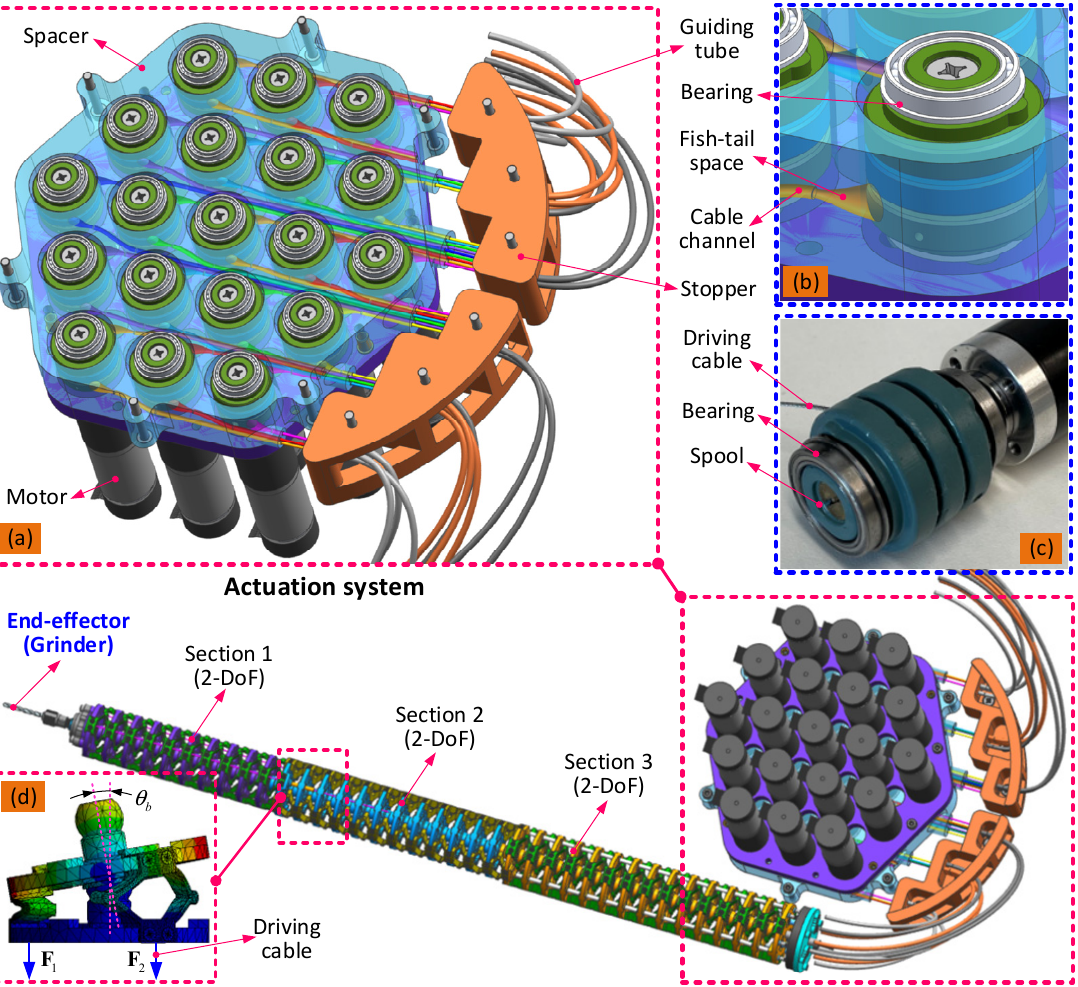
Figure 2. Detailed structural schematic of the dual-arm continuum robot: ( a ) is the overall structure of the continuum robot with the extended dual continuum arms, ( b ) is the internal structure of the actuation pack, ( c ) is the actuation principle for the continuum arms [8,26,27], ( d ) is the cable guiding system for controlling the continuum arm and